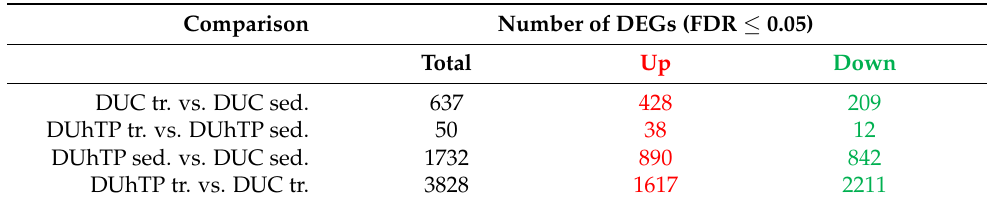
Table 1. Overview of differentially expressed genes (DEGs) in the pituitary glands from trained